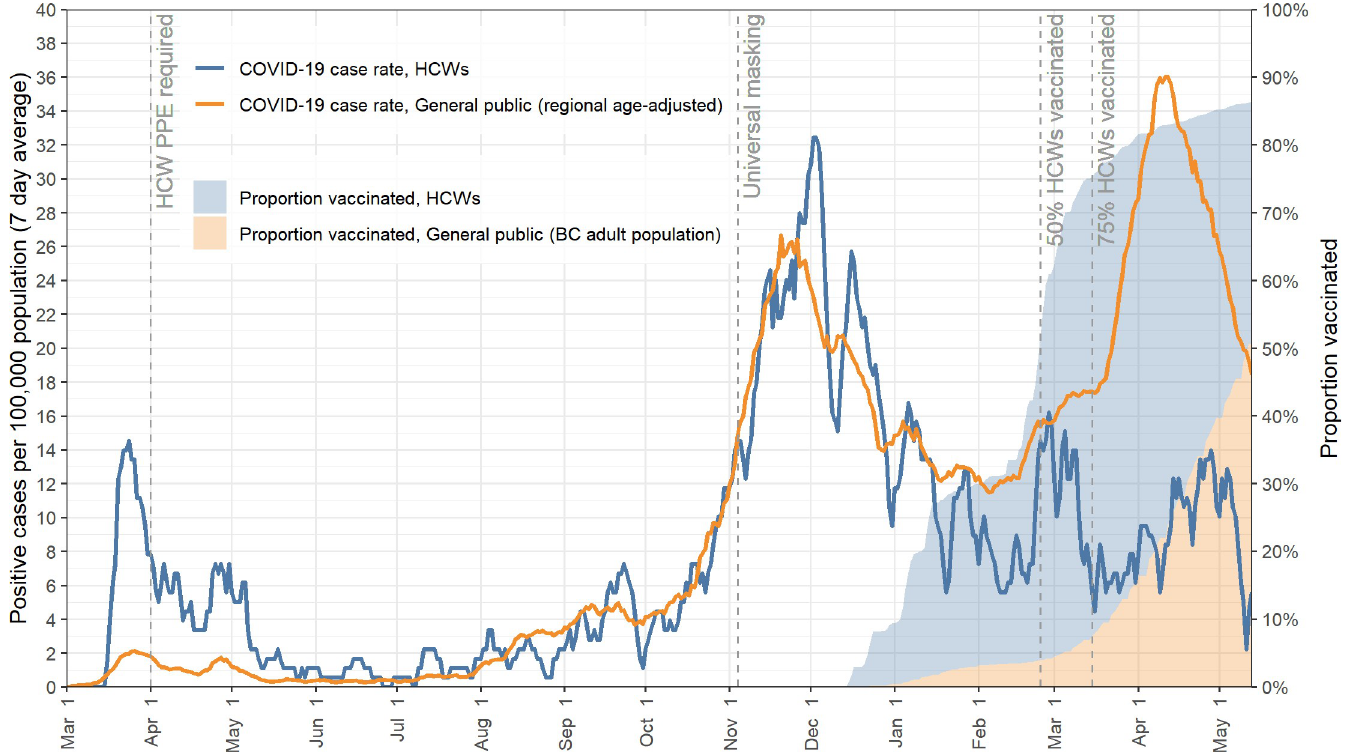
Fig 1. COVID-19 incidence rates and vaccine coverage in healthcare workers of Vancouver Coastal Health compared to adjusted general population in area of residence over time.